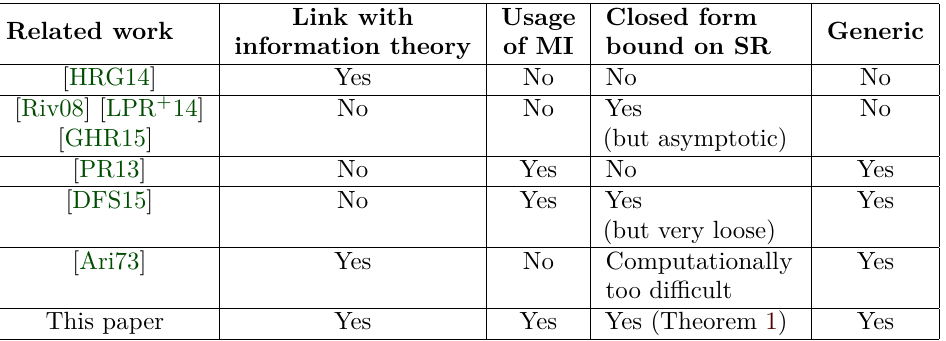
Table 1: Summary of the related